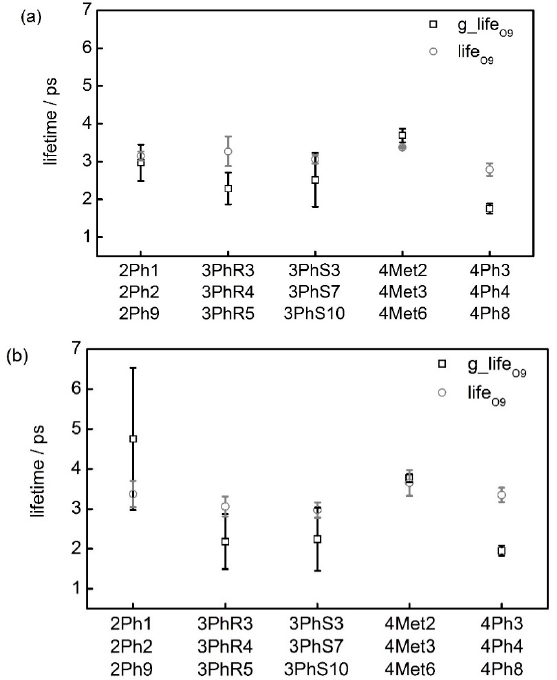
Figure 4. Comparison of the average lifetimes (in ps) of the uninterrupted hydrogen bonds of O9 ( a ) and O9 ′ ( b ) derived from ChemNetworks (life) and Gromacs (g_life) analysis for different molecules.